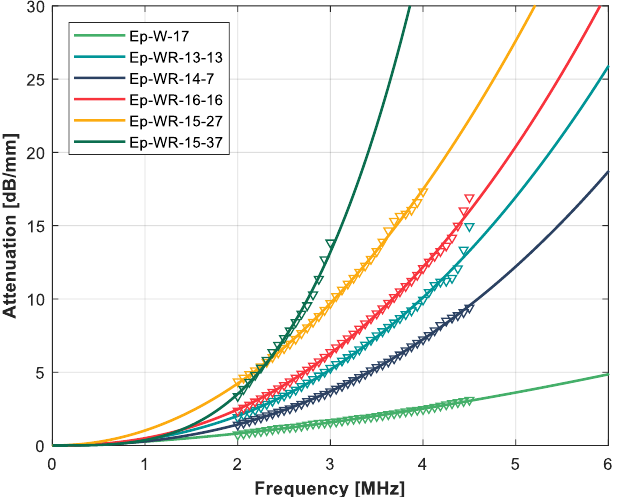
Figure 7. Variation in the ultrasonic attenuation coefficient with the frequency for the rubber + tungsten-loaded epoxy resin composites. Low impedance series. Open circles: measurements. Solid line: fitting using a power law.